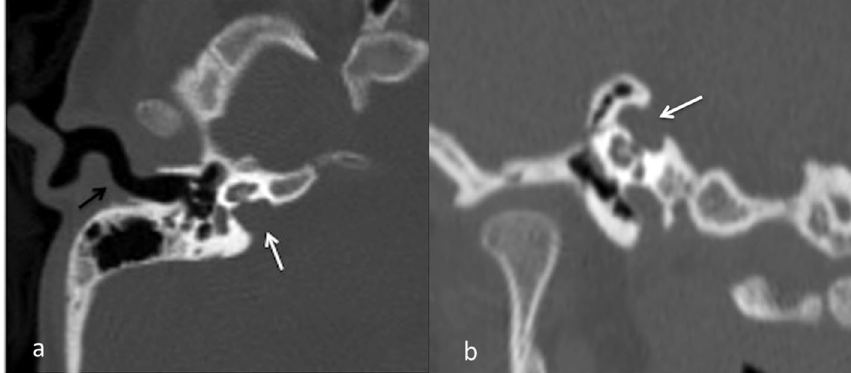
Fig. 1 Axial ( a ) and coronal ( b ) oblique reformatted CT image shows right IAC (white arrows) and right EAC (black